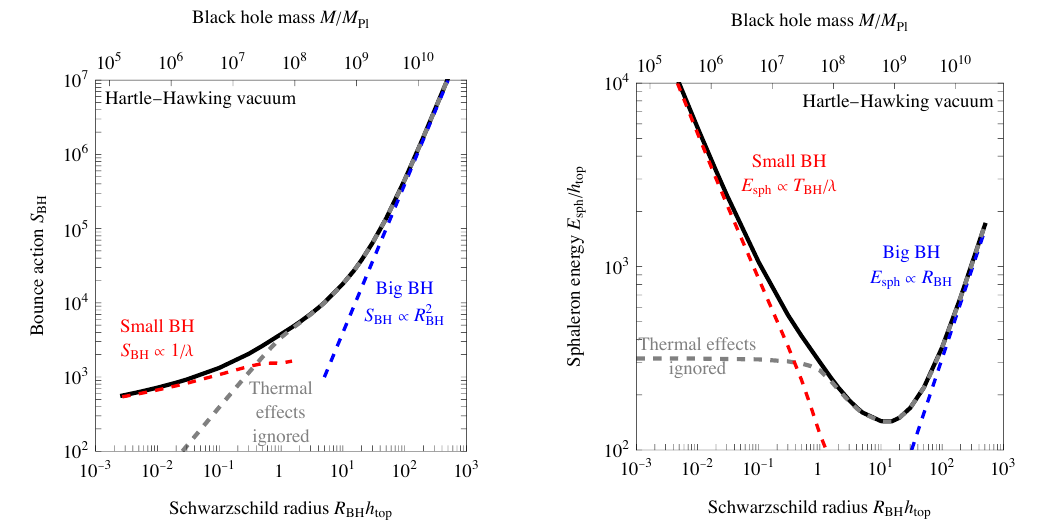
Figure 1 . Bounce action S BH = E sph /T BH (left) and equivalent sphaleron energy E sph (right) as function of the Schwarzschild radius R BH in units of the inverse instability scale h top . Only the black hole mass on the upper axis depends on h top , here fixed to 10 11 GeV (cid:28) M Pl . Black curve: numerical result, assuming the Hartle-Hawking vacuum. Blue dashed curve: asymptotic limit for big cold black holes, see section 3. Red dashed curve: asymptotic limit for small hot black holes, see section 4. Gray dashed curve: vacuum decay is fast if thermal-like effects are neglected. Results do not depend on the non-minimal coupling ξ of Higgs to